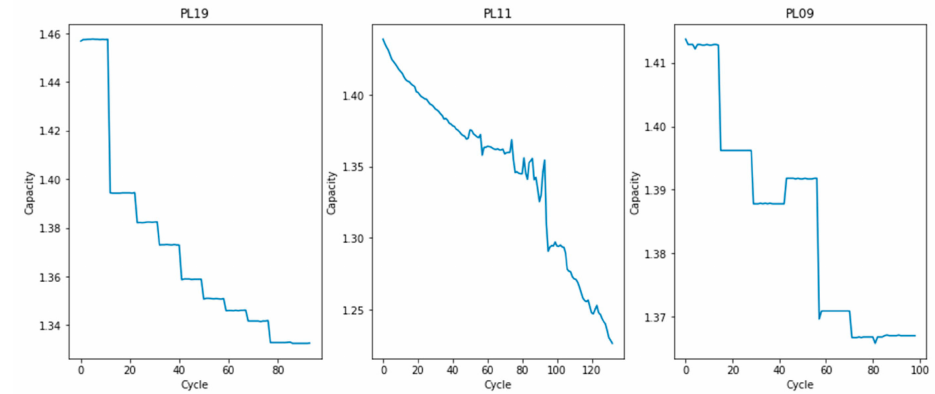
Figure 2. Capacity vs. Cycle for PL11, PL19, and PL09.